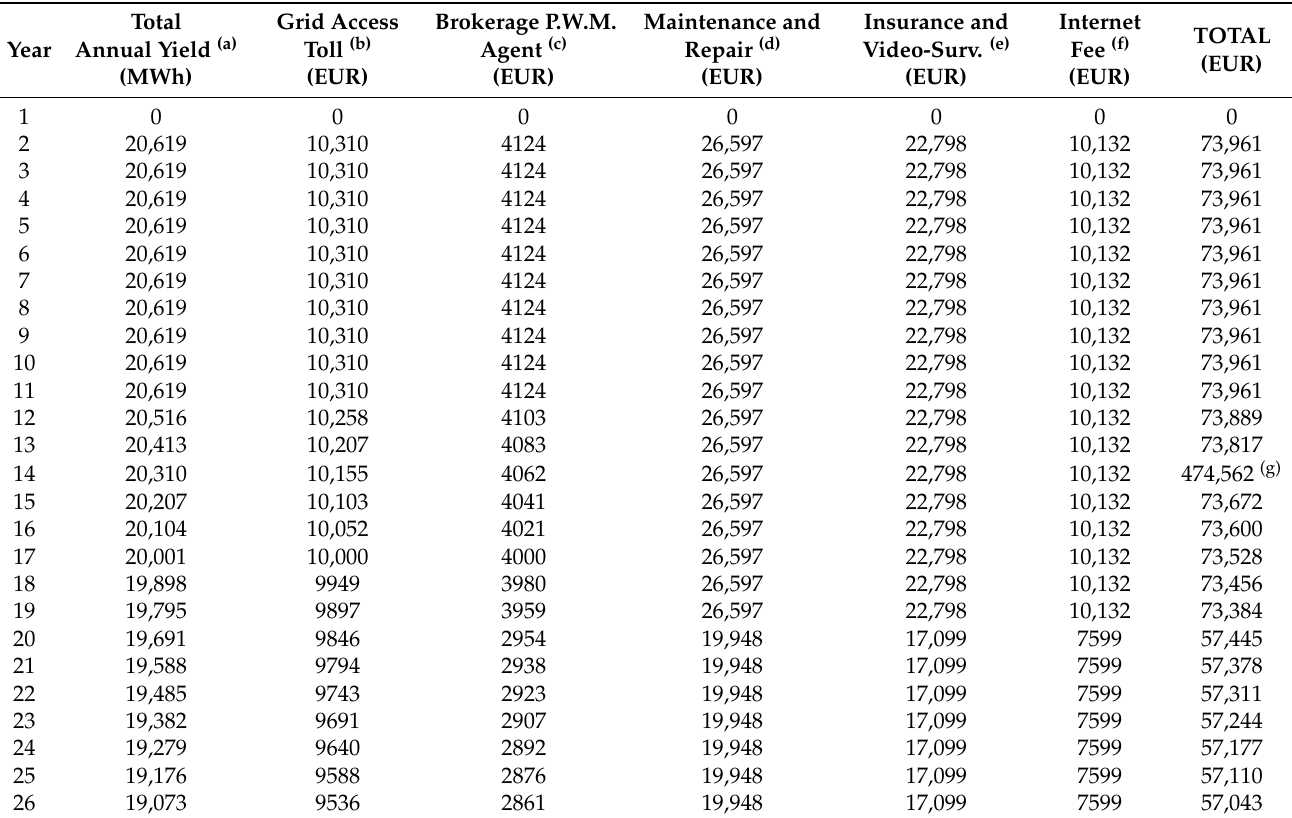
(a) From Table 8. (b) 0.5 EUR/MWh [73]. (c) p.w.m., power whosale market. Brokerage fee applied: 0.2 EUR/MWh [74], years 2 through 19; years 20 through 26: assumption of 25% price decrease applied [69], resulting in 0.15 EUR/MWh. (d) Years 2 through 19, (2.1 EUR/kWp) · (555.5 kWp/ha) · (22.8 ha) = 26,597 EUR; years 20 through 26: assumption of 25% price decrease applied